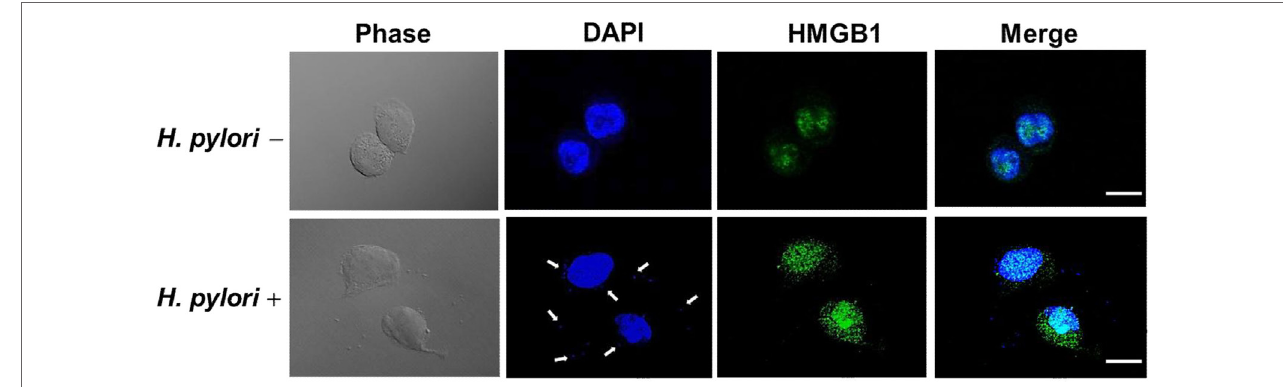
FigUre 3 | hMgB1 expression in response to H. pylori infection . AGS cells were uninfected or infected with H. pylori (MOI = 100) at 37°C for 6 h. Cells were fixed and probed with antibody against HMGB1 (green) or stained with DAPI (blue) to visualize cell nuclei and H. pylori (arrows). The stained samples were analyzed by confocal microscopy. Scale bars, 10 μ